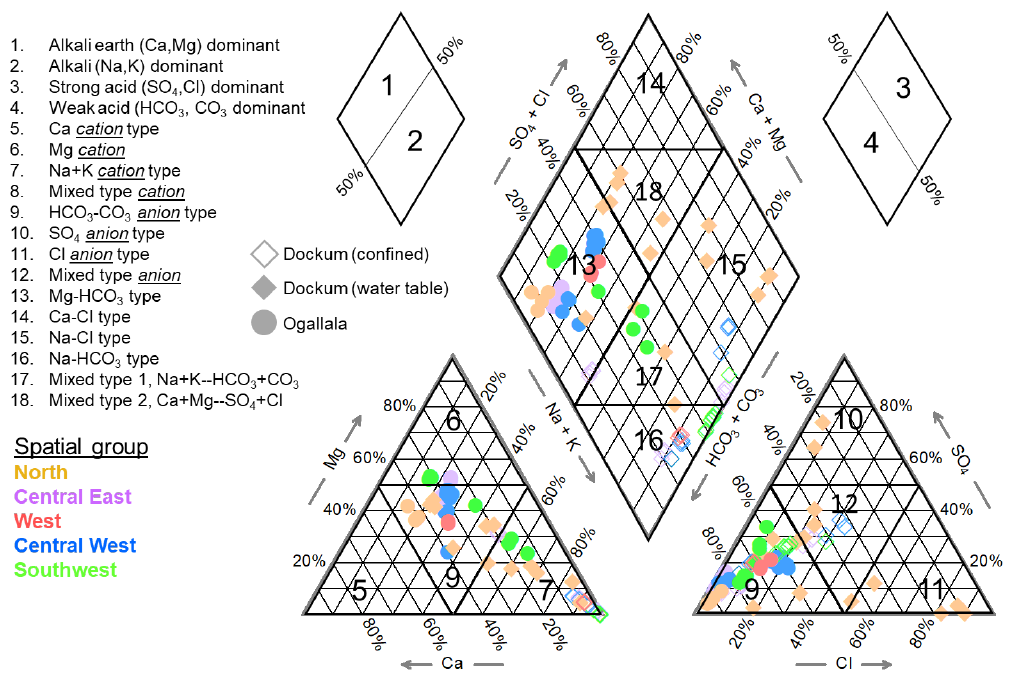
Figure 9. Piper trilinear diagram presenting hydrochemical facies for all recently collected (2014–15) groundwater samples, organized according to aquifer unit. Table 6. Groundwater study samples by hydro chemical class. All percentages are in reference to